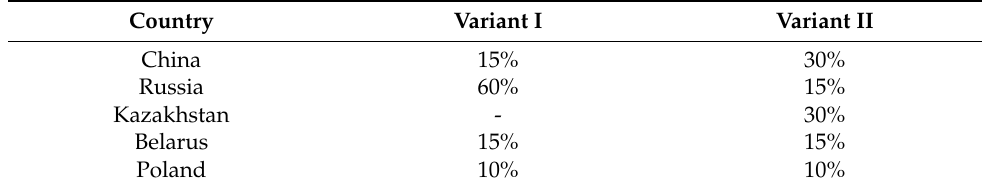
Table 9. The percentage share of infrastructure on the railway route for the two variants.